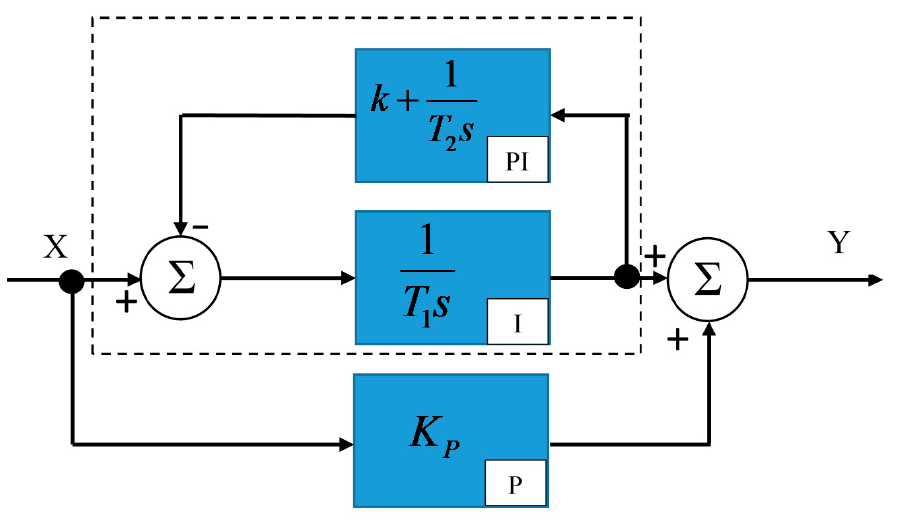
Figure 2. Proposed structure of the P+R controller [22].